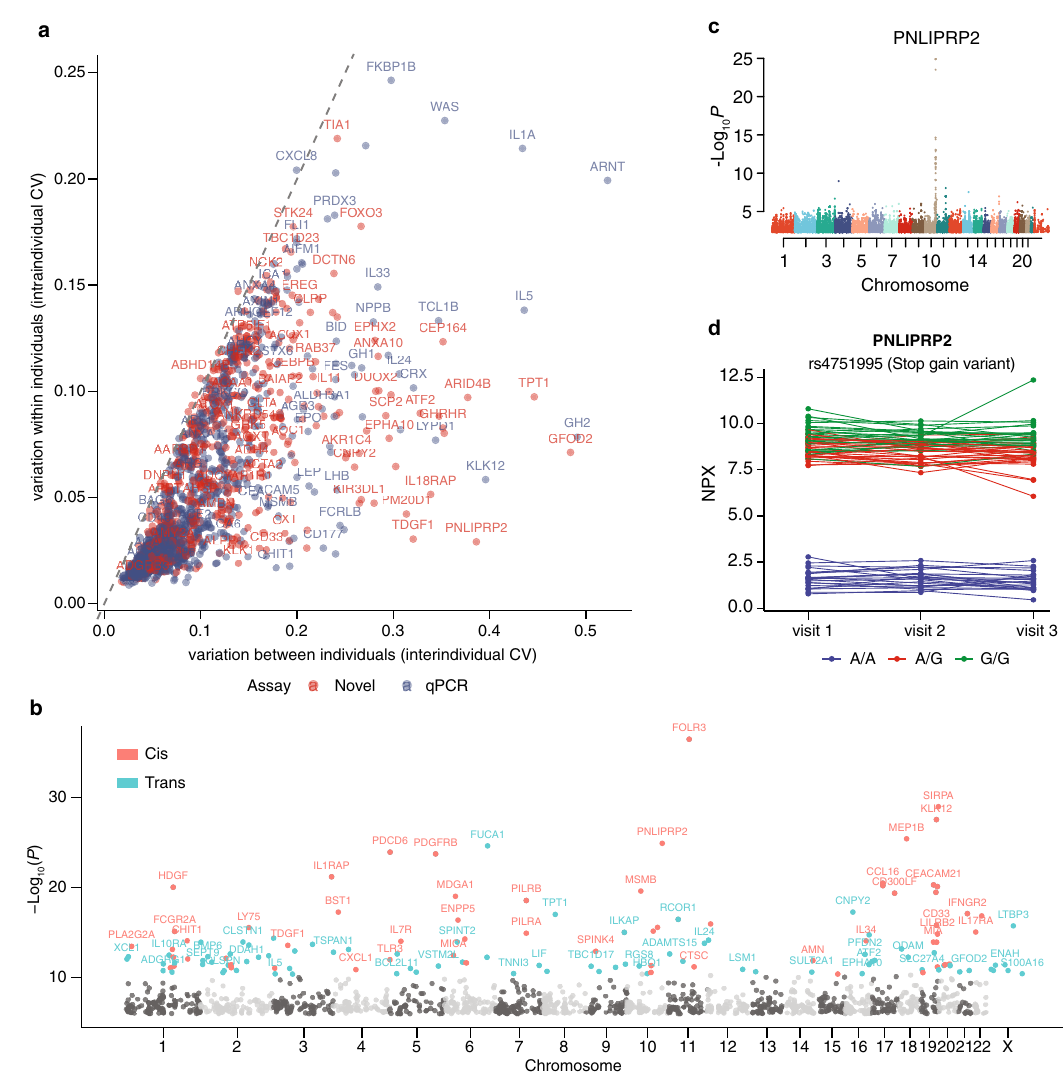
Fig. 3 Variability of the plasma protein pro fi ling and protein quantitative trait loci (pQTL). a The inter-individual and intra-individual variation of protein levels calculated as the mean coef fi cient of variation (CV) for each protein within each visit and across all analyzed individuals ( n = 76) in the wellness cohort, and as the mean CV for each protein within each individual across all visits ( n = 3), respectively. b Manhattan plots of the sentinel pQTL per protein visualizing the cis-pQTLs and trans-pQTLs for all proteins with signi fi cant associations. The light and dark grey dots represent the not signi fi cant associations split into chromosome location. c Manhattan plot of protein PNLIPRP2 shows the genome locations of all associated pQTLs. d The longitudinal protein concentration across visits one to three with each individual connected with a dotted line for PNLIPRP2, colored by the different variants. Source data are provided as a Source Data fi